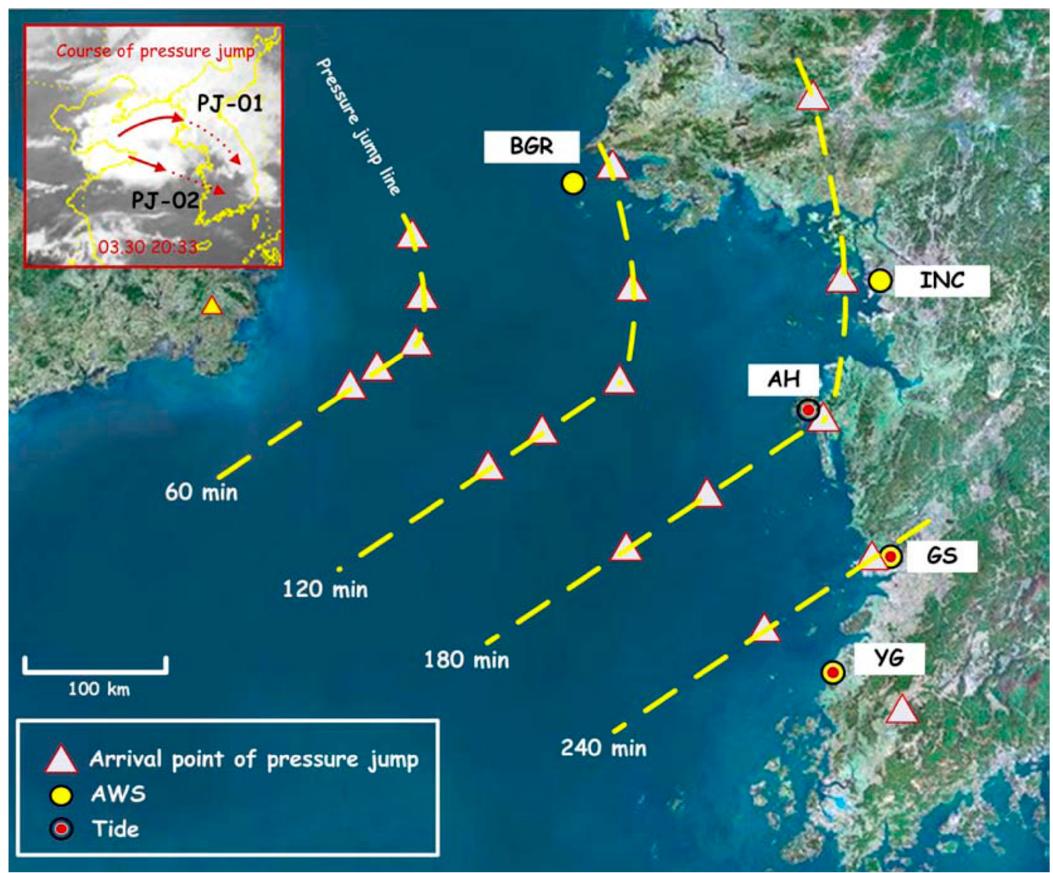
Figure 4. Estimation of the traveling path of the pressure jump over the Yellow Sea during the meteotsunami that occurred in March 2007 [7].